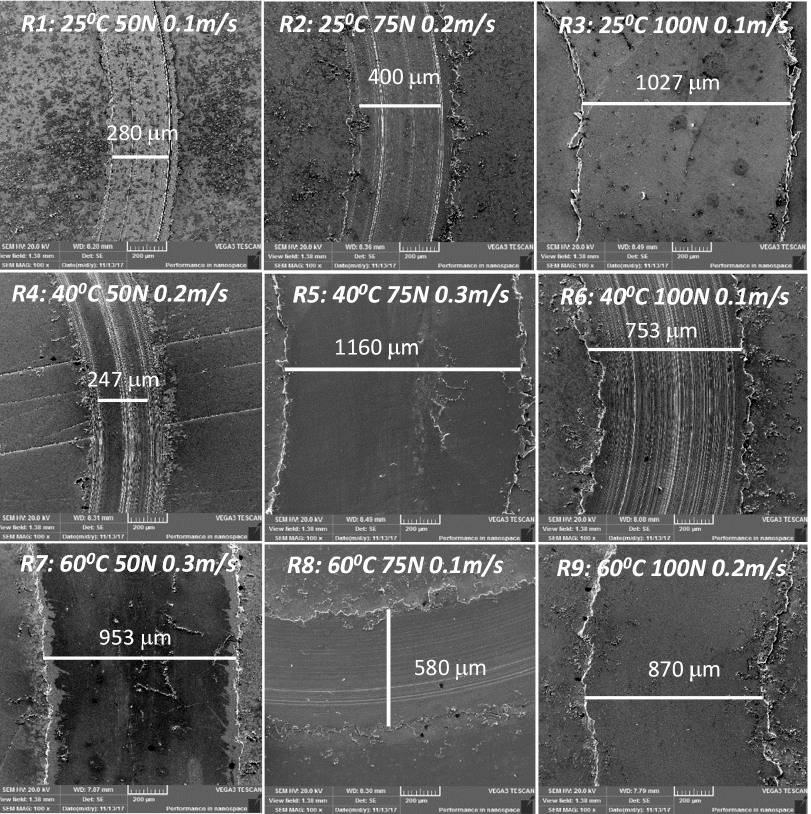
Figure 6. Scanning Electron Microscopy (SEM) images of the wear track after the test at different conditions at a magnification of 100×. Materials 2018 , 11 , x FOR PEER REVIEW